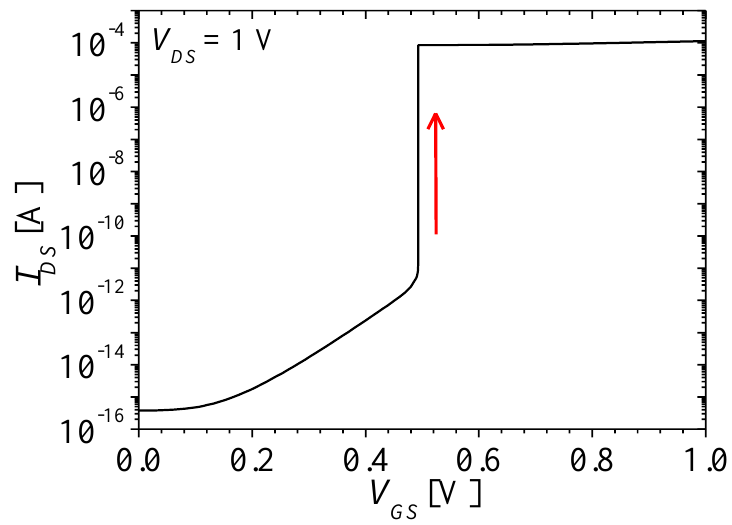
Figure 3. Drain − source current − gate − source voltage ( I DS - V GS ) characteristics of NFBFET at V DS = 1 V.